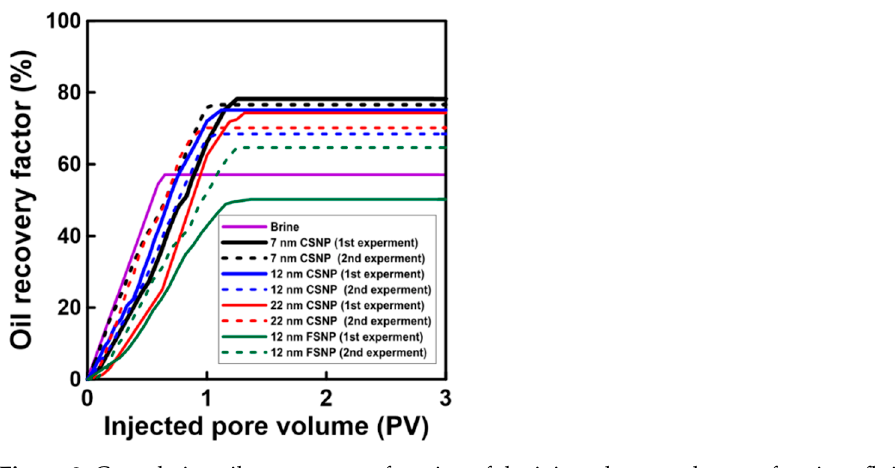
Figure 9. Cumulative oil recovery as a function of the injected pore volumes of various fluids.